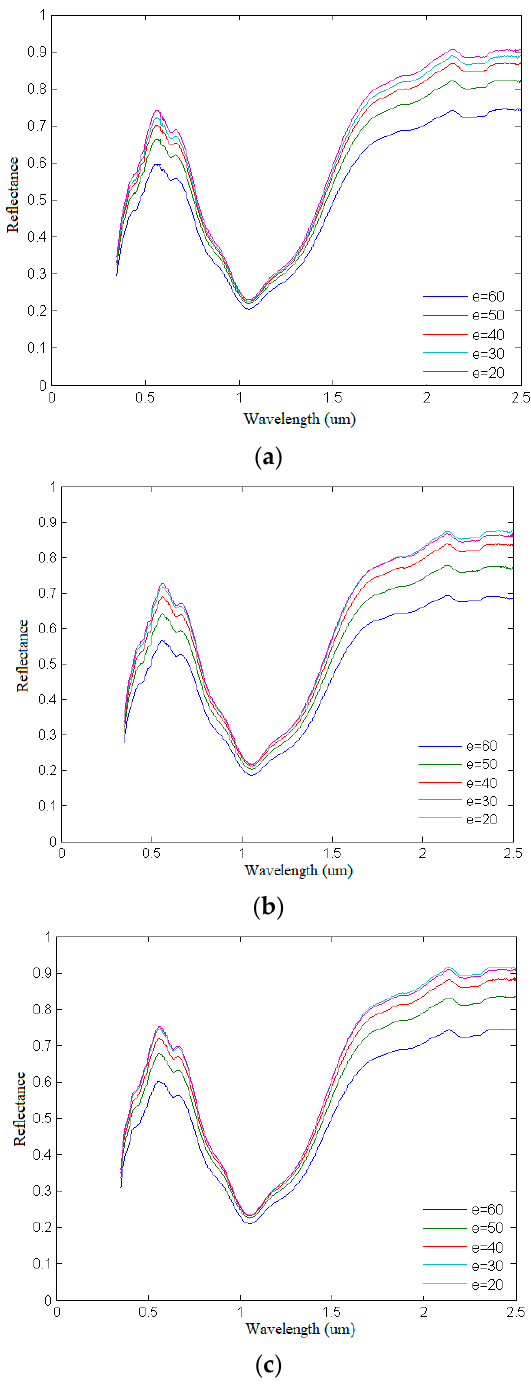
Figure 4. Measured multi-angle spectral data of olivine (i.e., incidence angle, emittance angle and azimuth angle), including five multi-angle spectra at an incident angle of 0° and azimuth angle of 180° ( a ); five multi-angle spectra at an incident angle of 0° and azimuth angle of 210° ( b ); and five multi-angle spectra at an incident angle of 0° and azimuth angle of 240° ( c ). Similar to the olivine spectrum collection, for the spectrum curve of plagioclase with an incident angle of 0 ◦ , azimuth angles of 180 ◦ , 210 ◦ and 240 ◦ , and different exit angles